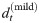
Posterior distribution of time-dependent unknowns.Panels A and B: the true incidence in absolute and log scales. The detected numbers are shown for reference. Panel C: the cumulative age distribution of infected individuals. Panel D: the estimated number of immune individuals per week. Panel E: the basic reproduction number R0,t = R0
wt per week. Panel F: the probability of detecting mild infection per week dt(mild). The full posterior distributions are visualized, with more probable values represented by darker color. In addition, a few samples from the posterior are shown. The shaded areas mark the epidemic seasons.